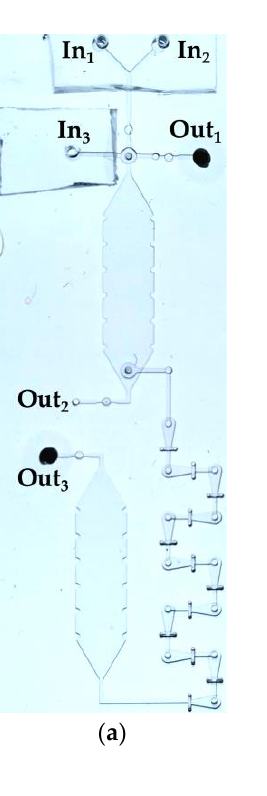
microscope µ-Surf; Figure S2: Closing curve diagram for three hydrogels (400 drops, 60 s UV expo- sure time) in ventil seats of 425 µm diameter; Video S1: Printing with PEG into a hole with diameter 500 µm located in 175 µm thick PMMA foil; Video S2: Printing with prepolymer solution (450 drops with 550 pl each) on PMMA substrate with 600 µm diameter engraving; Video S3: Unrestricted fluid